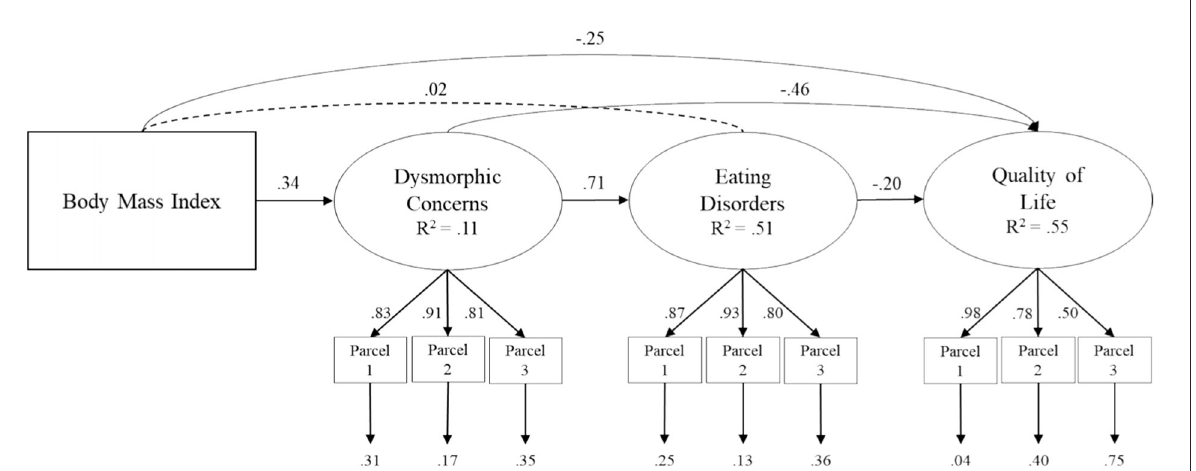
FIGURE1 Structural model of association between body mass index, dysmorphic concerns, eating disorder and quality of life of life in individuals with PCOS. Coefficient shown are standardized path coefficients. Dotted lines represent not significance